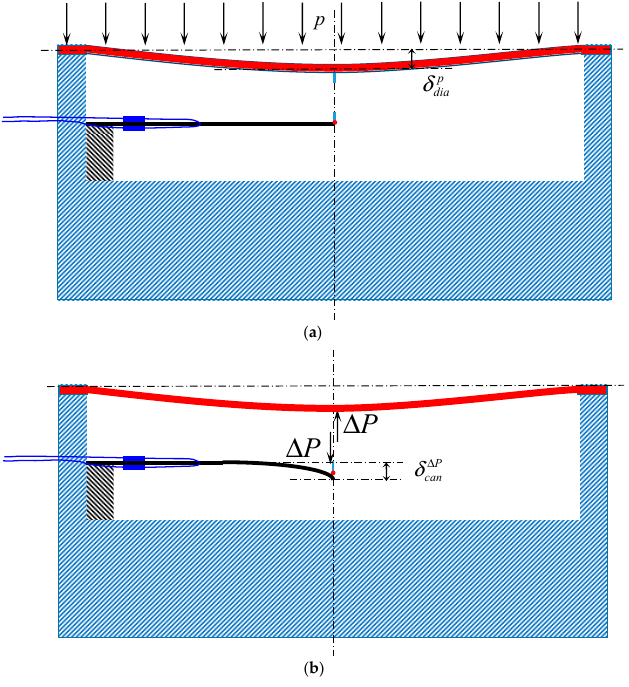
Figure 4. Working principles of the proposed FPS: ( a ) The deflection of diaphragm under an external force p ; ( b ) the deflections of diaphragm and cantilever beam due to internal force ∆ P .